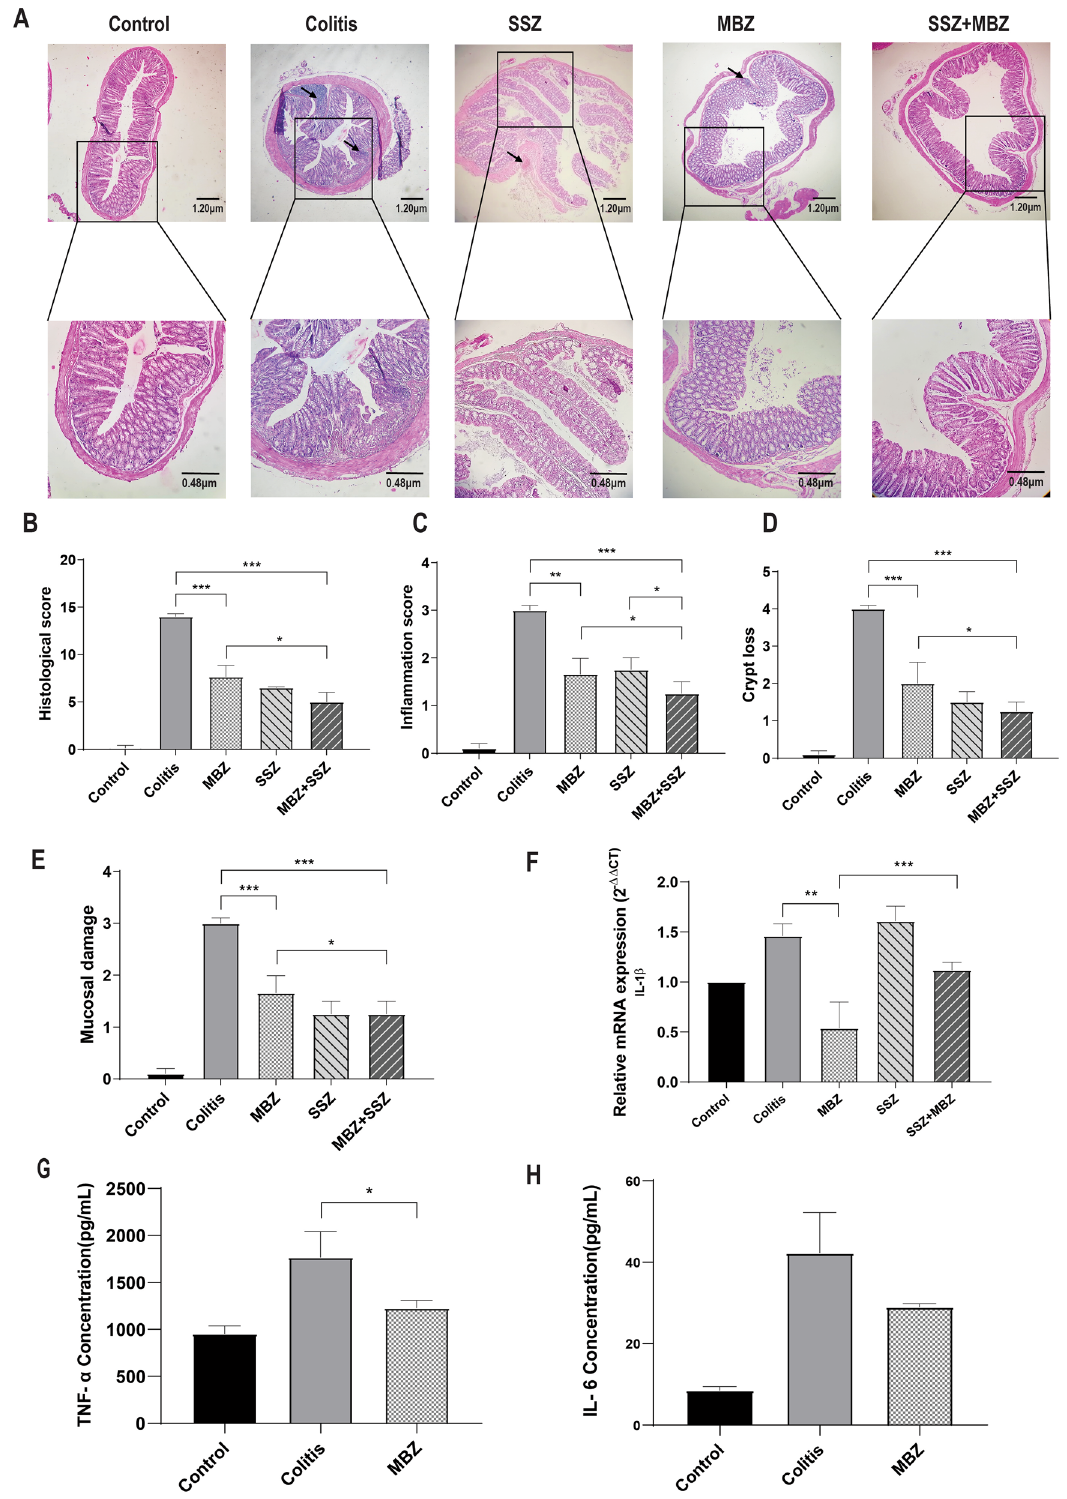
Figure 3. Mebendazole (100 mg/kg/day) reduced DSS-induced colon tissue inflammation. ( A ) Histologic sections of the colon are shown after undergoing hematoxylin and eosin (H&E) staining in the colitis tissues indicating the protective effect of MBZ or MBZ + SSZ on histological damages induced by DSS administration. Arrows indicate inflammatory cells infiltration. ( B ) Quantifying the effect of mebendazole on the histological score, ( C ) inflammation score, ( D ) crypt loss, and ( E ) mucosal damage in DSS-induced colitis mice. ( F ) Mebendazole significantly reduced the mRNA expression of IL-1β in colon tissue compared to the DSS group. ( G ) Mebendazole significantly reduced tissue concentrations of TNF-α protein, ( H ) The same as G, except that the effect of MBZ on IL-6 concentration was evaluated. * P < 0.05, ** P < 0.01, *** P < 0.001. Data were presented as Mean ± SEM, One-way ANOVA followed by post-hoc LSD test. Data are representative of three independent experiments with 6 mice in each group (n =